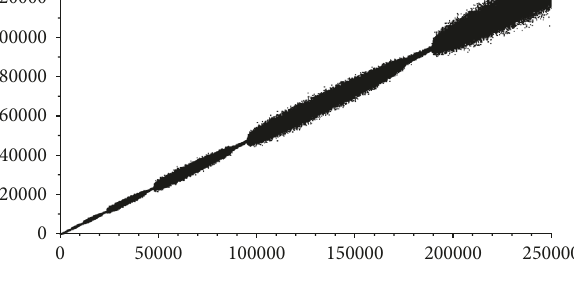
Figure 1: Hofstadter 𝑄 -sequence.